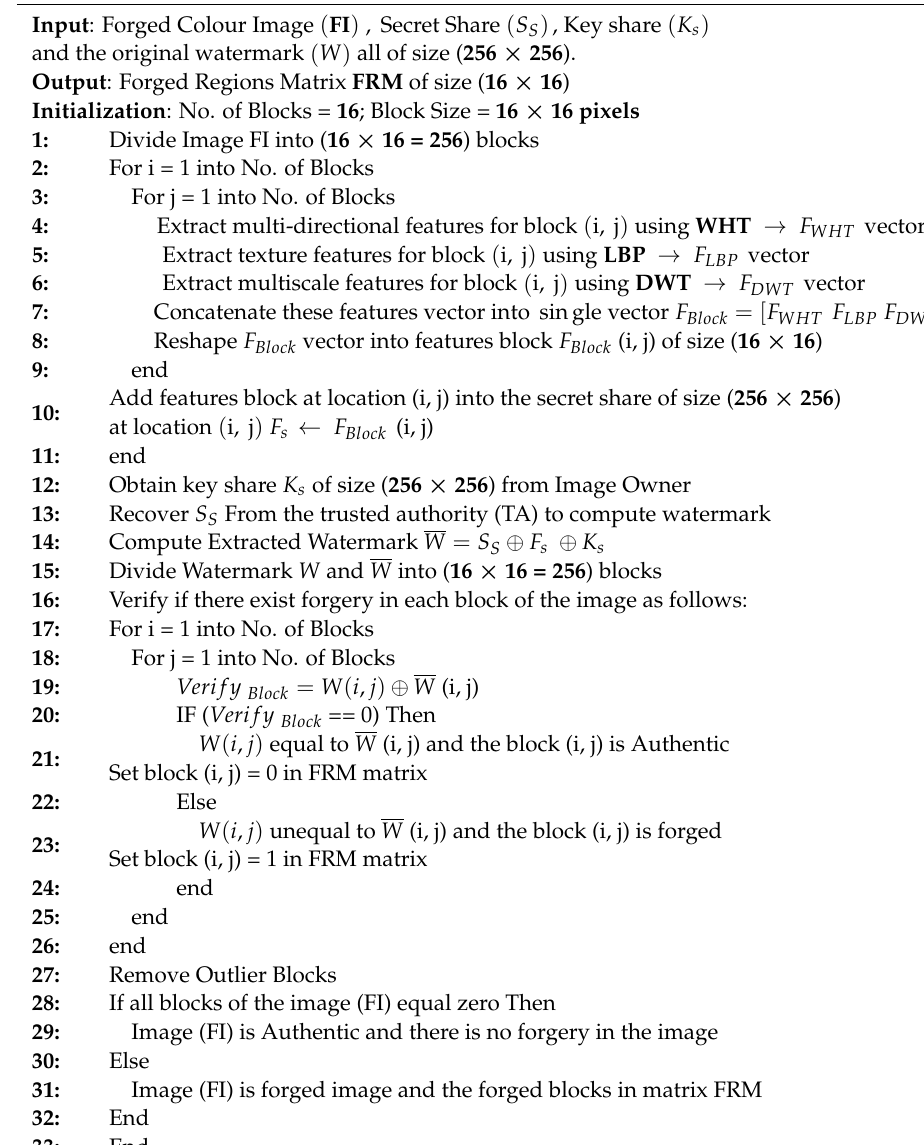
Algorithm 2: Image Forgery Verification